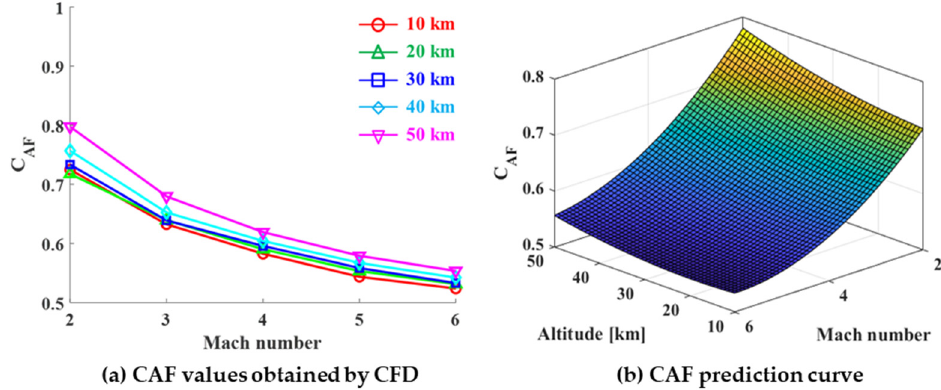
Figure 9. Results with Mach number and altitude for free-fall flight phase. ( a ) CAF values obtained by CFD; ( b ) CAF prediction curve.